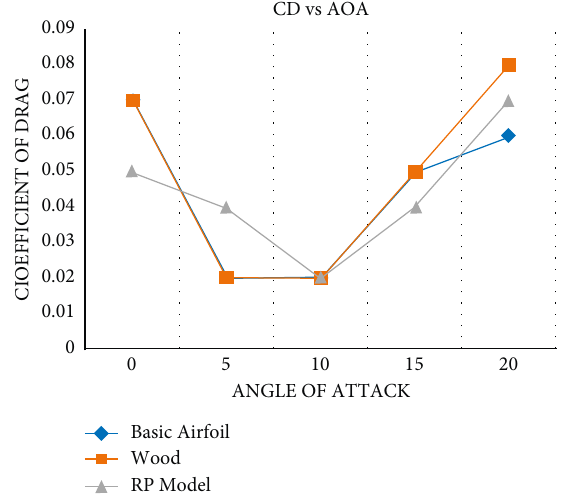
Figure 24: Plot between C